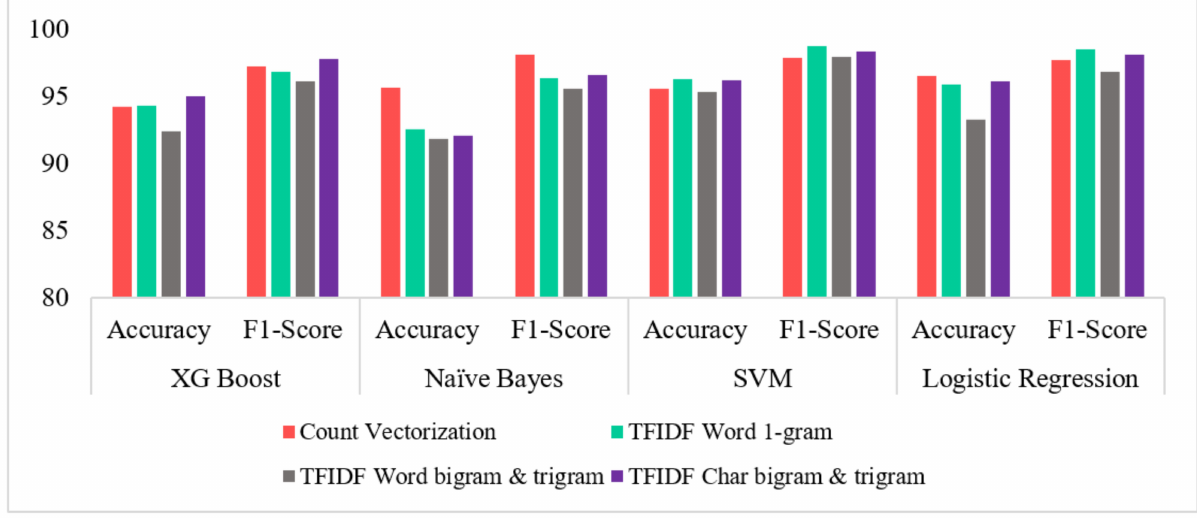
Figure 9. Performance comparison of traditional machine learning on Wikipedia Web Toxicity